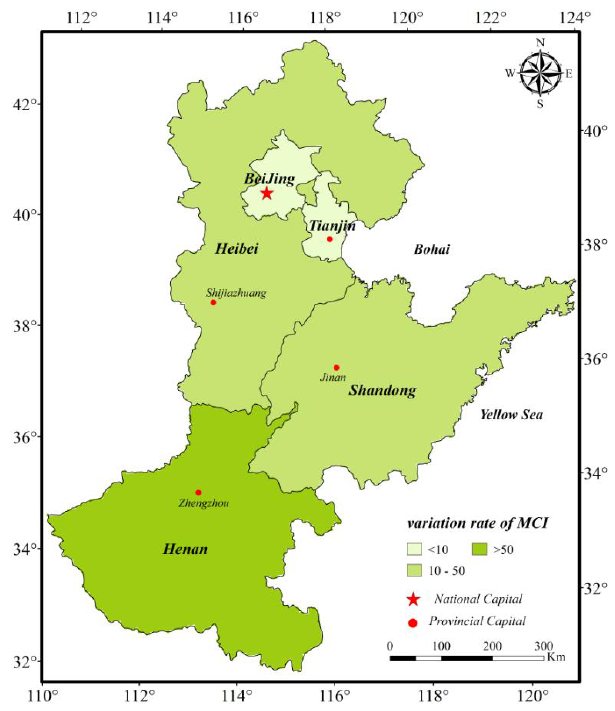
Figure 10. Variation rate of Multiple Cropping Indices of every city/province in the North China Plain between 1982 and 2012.